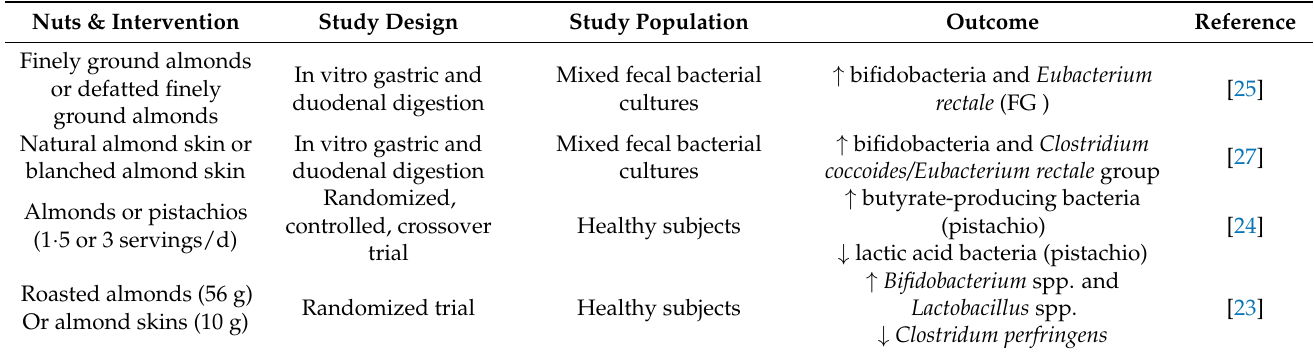
Table 5. Functional food